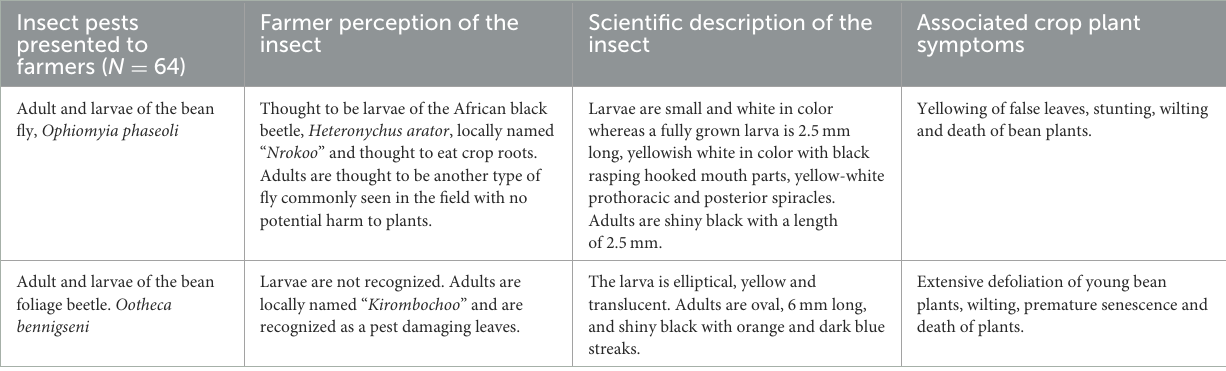
TABLE 4 Summary of 64 farmers’ responses during focus group discussions done in Narumu Ward, Kilimanjaro region, Tanzania showing perceptions about key pest insects infesting common bean plants when farmers were shown color images and dead specimens of the insect in comparison to actual scientific